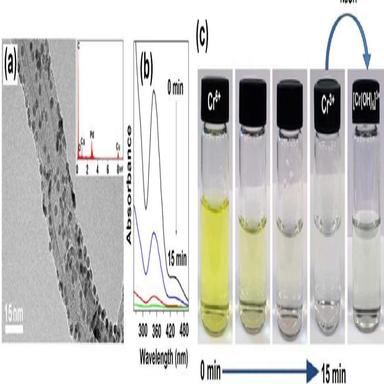
(a) TEM image of Pd-CNTs and the corresponding EDX spectrum (inset), (b) Representative time-dependent UVevis absorption spectra for the reduction of Cr(VI) in the presence of the Pd-CNT catalyst in an aqueous medium, and (c) Photographs of the reaction solution produced by the Pd-CNT-catalyzed reduction of Cr(VI) and the formation of 3 anions.